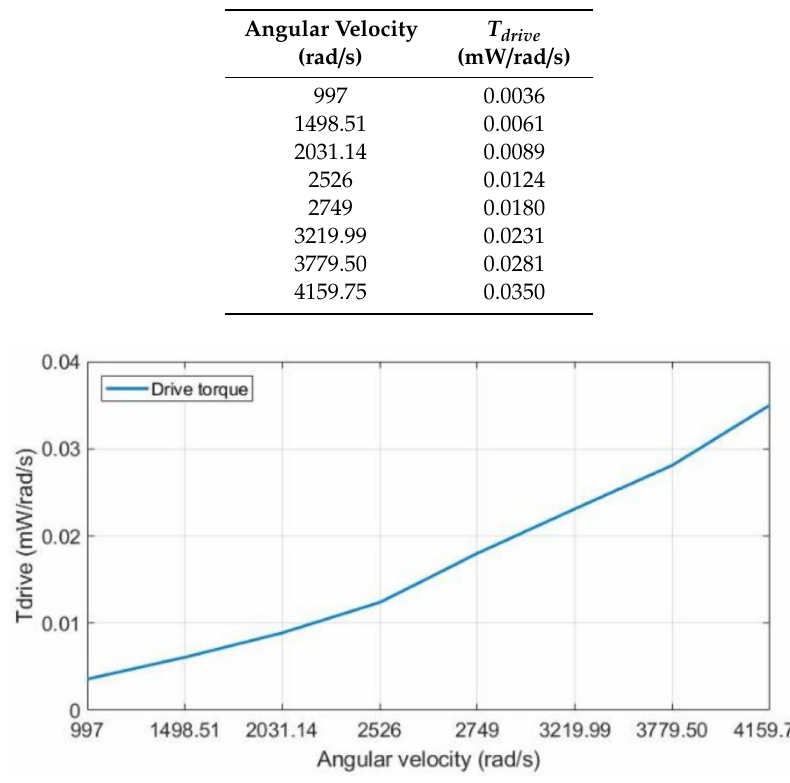
Table 4. Numerical values of the torque vs. angular velocity.